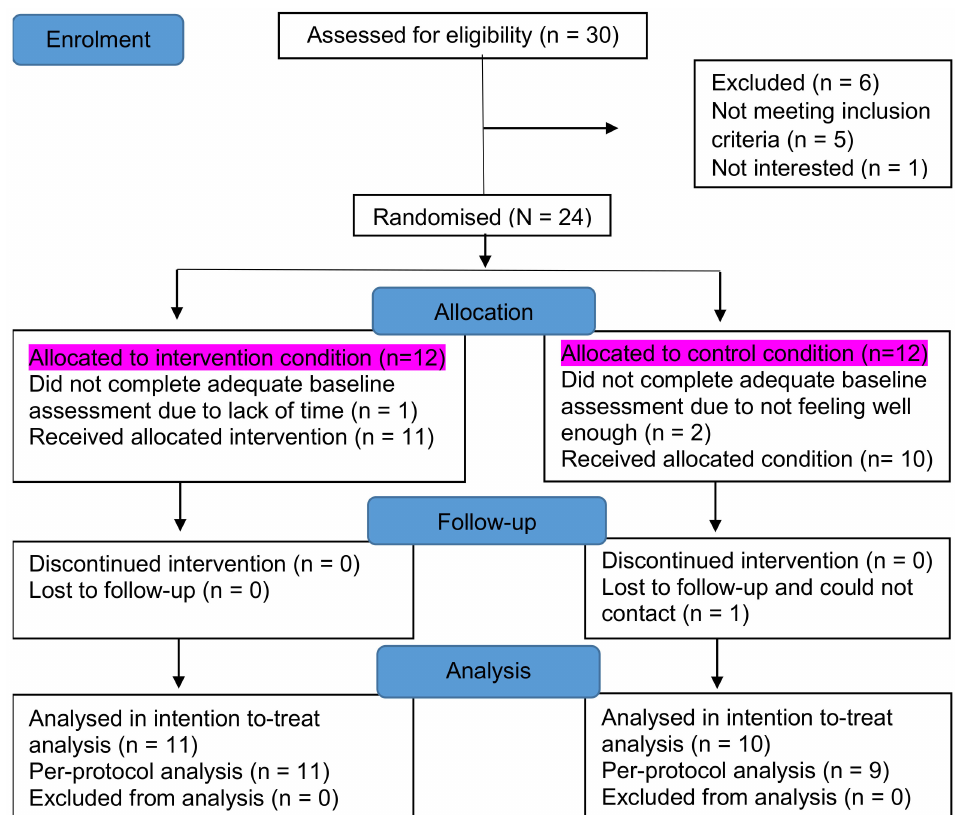
Figure 1. Flow diagram of participants through the